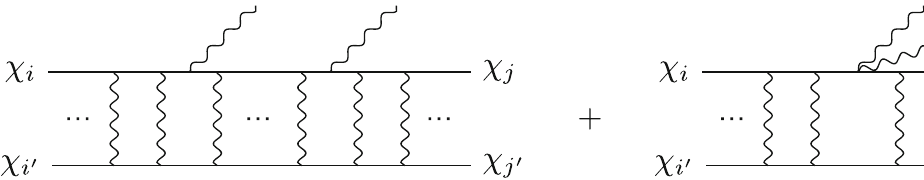
between the two emission reconstructs the wave function of an interme- diate BS or scattering state. The second diagram, instead, is obtained from the O ( A 2 ) terms in the interaction Hamiltonian, at leading order in the Born